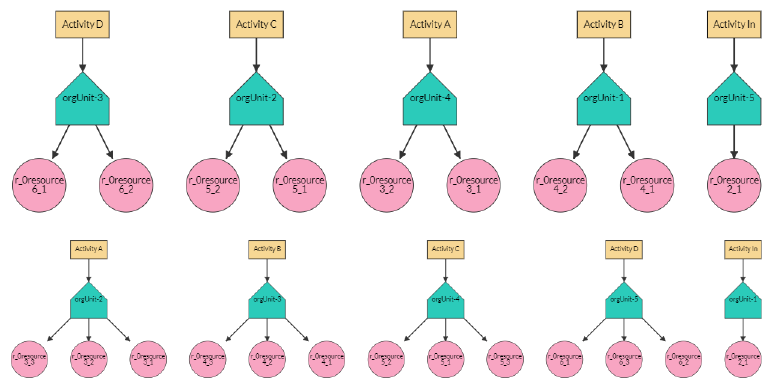
Figure 7. Resource allocation of each activity for scenario 1 and scenario 2.